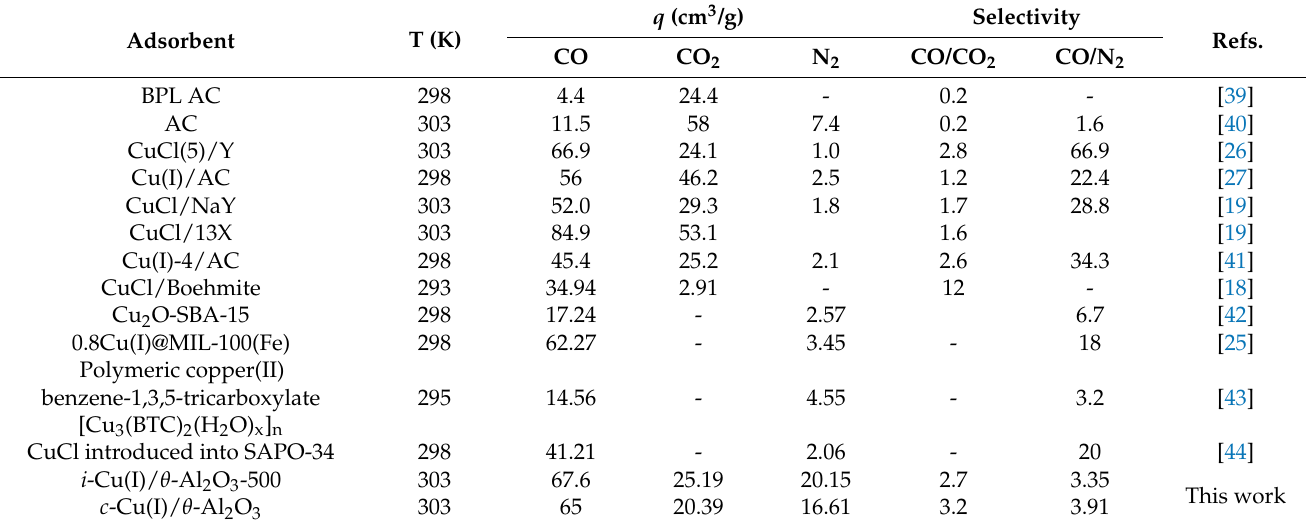
Table 1. Comparison with other reported